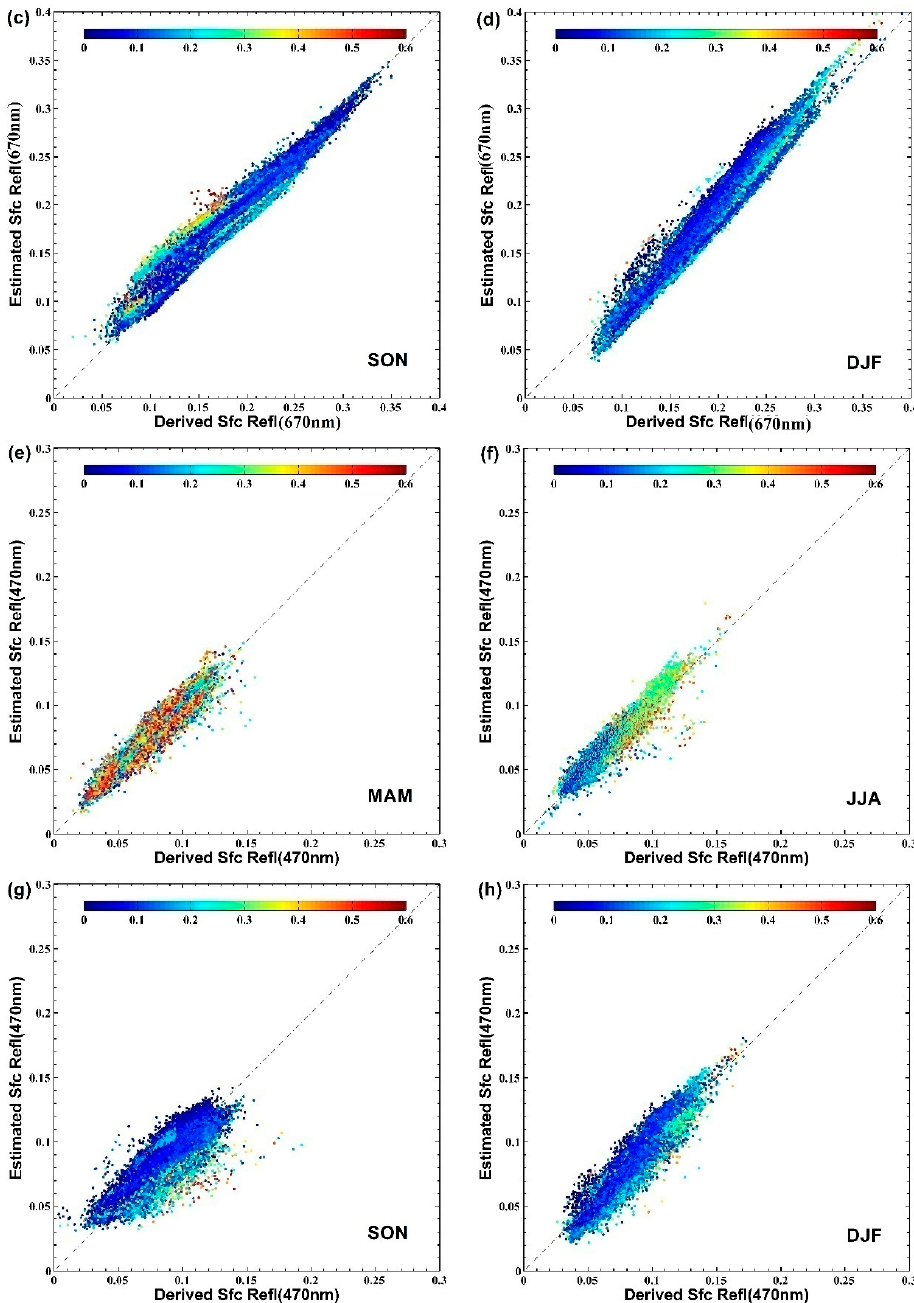
Figure 4. Comparisons of the estimated surface reflectance at 0.67 µm ( a – d ) and 0.47 µm ( e – h ) with the surface reflectance from MOD09 for four seasons. ( a , e ) for MAM, ( b , f ) for JJA, ( c , g ) for SON, ( d , h ) for DJF. The colors of the symbols indicate the AOD value at 0.55 µm. In addition, we also calculated season-average surface reflectance at 0.47 and 0.67 µm channels for 2009 based on SAHARA regression coefficients listed in Tables 2–9 and DB coefficients [6], respectively. SAHARA and DB estimated surface reflectances are also compared to the MOD09 surface reflectance products in two visible channels as shown in Figure 5 (0.47 µm) and Figure 6 (0.67 µm). All three surface reflectances show similar distribution. The surface reflectances are